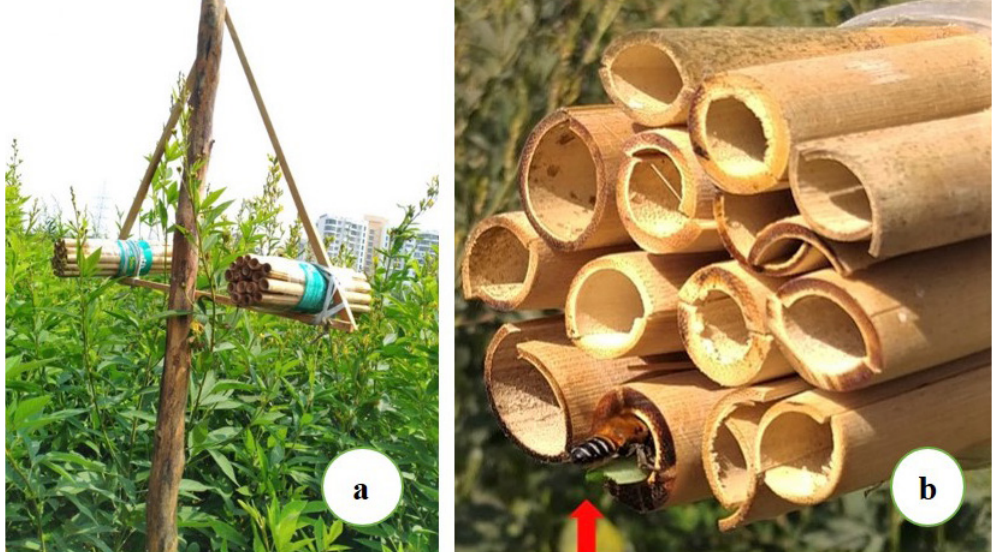
Fig 1 . a . Trap nest installation in a Cajanus cajan (L.) Millsp. (Fabaceae) plantation of the experimental farm of ICAR-National Bureau of Agricultural Insect Resources (NBAIR) Bengaluru, Yelahanka Campus, India. b . Leaf cutter bee, Megachile Latreille, 1982 entering trap nest with a leaf